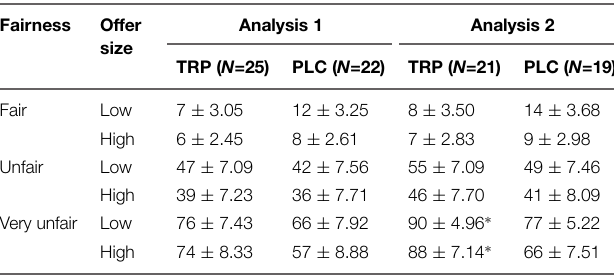
TABLE 2 | Ultimatum Game (UG), rejection rates following 6 days of TRP/PLC (M ±